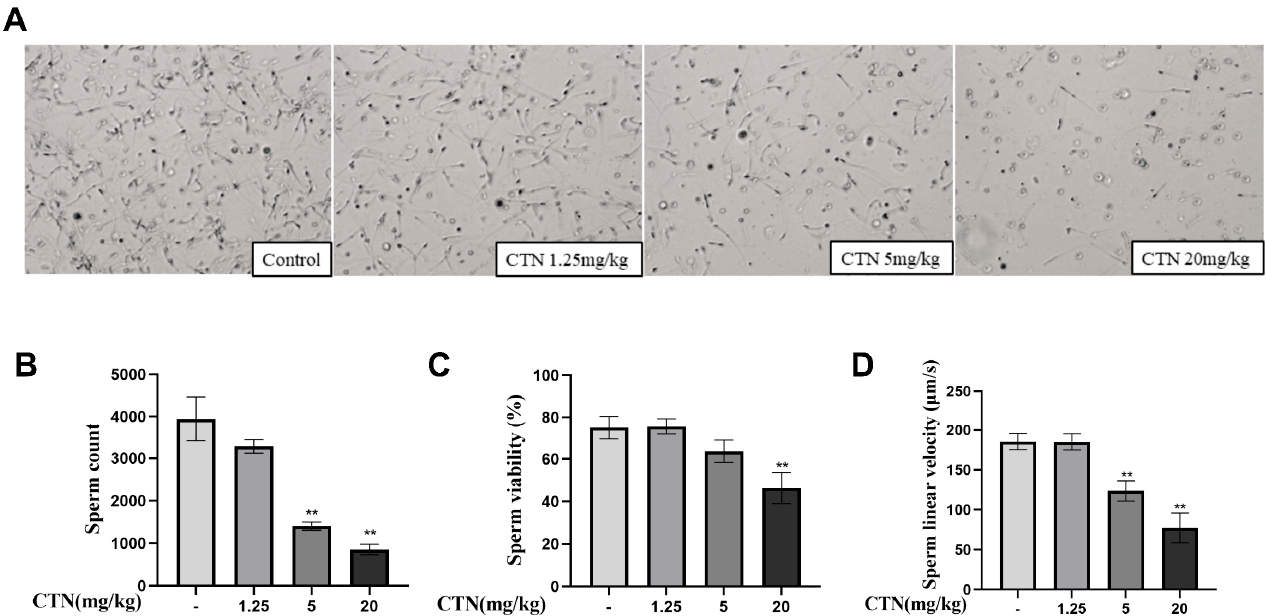
Figure 2. Effects of CTN on sperm quality in mice. ( A ) sperm count and morphology; ( B ) Sperm count; ( C ) Sperm viability; ( D ) Sperm linear velocity. The above data are expressed as SEM ± mean, compared with the control group, ** p < 0.01.